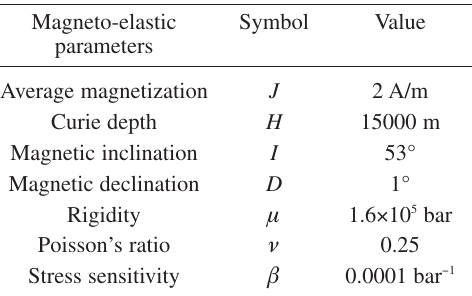
Table II. The magneto-elastic parameters estimated in the upper crust on Mt.